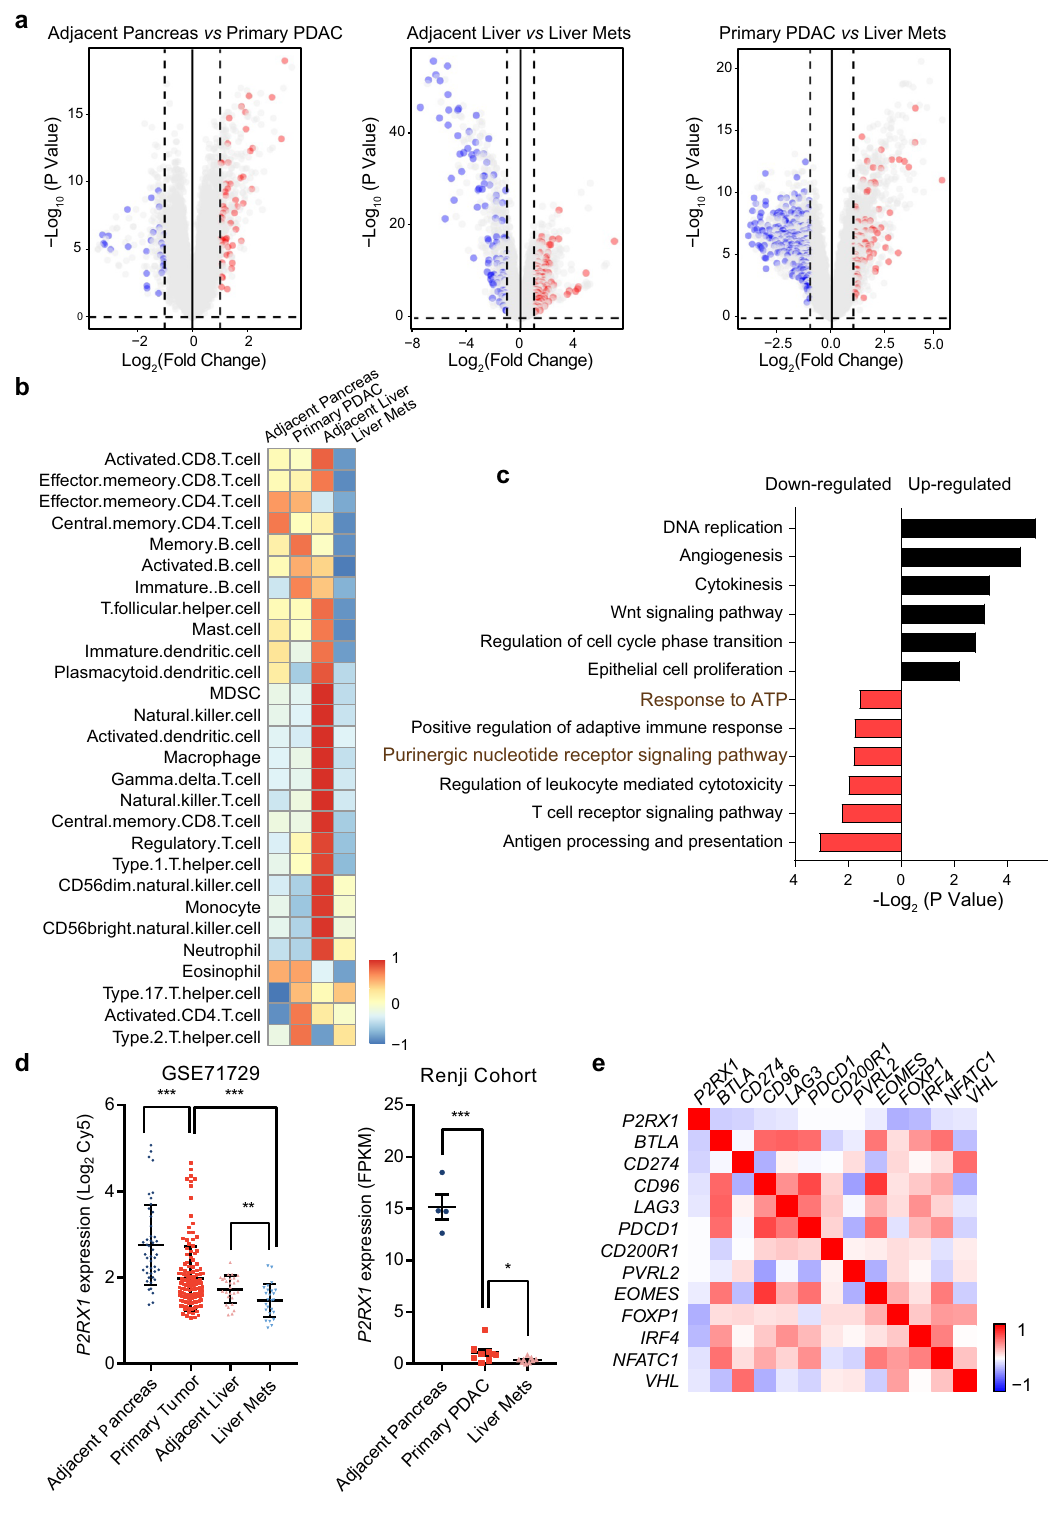
con fi rmed by our Renji Cohort RNA-seq data (GSE151580)